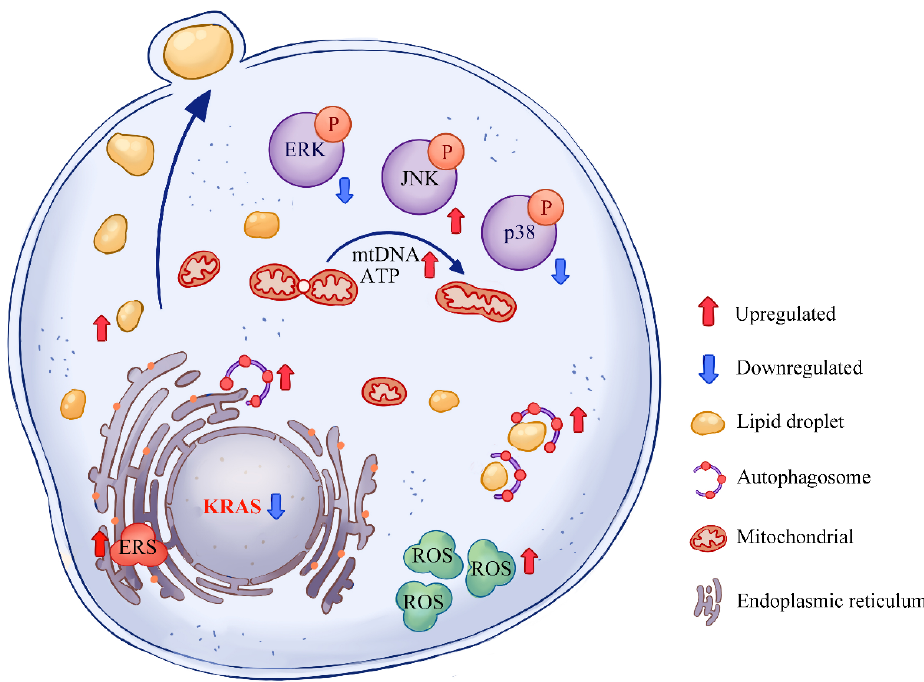
Figure 8. Schematic diagram of the effects of Kirsten rat sarcoma viral oncogene homolog (KRAS) inhibition in MAC-T cells. After KRAS inhibition, the levels of triglycerides, mitochondrial DNA (mtDNA), ATP, reactive oxygen species (ROS), autophagy, and endoplasmic reticulum stress (ERS) were upregulated in MAC-T cells. Moreover, the levels of mitogen-activated protein kinase (extracellular regulated protein kinases, ERK; c-Jun N-terminal kinases, JNK; p38) activation were regulated after KRAS inhibition in MAC-T cells.